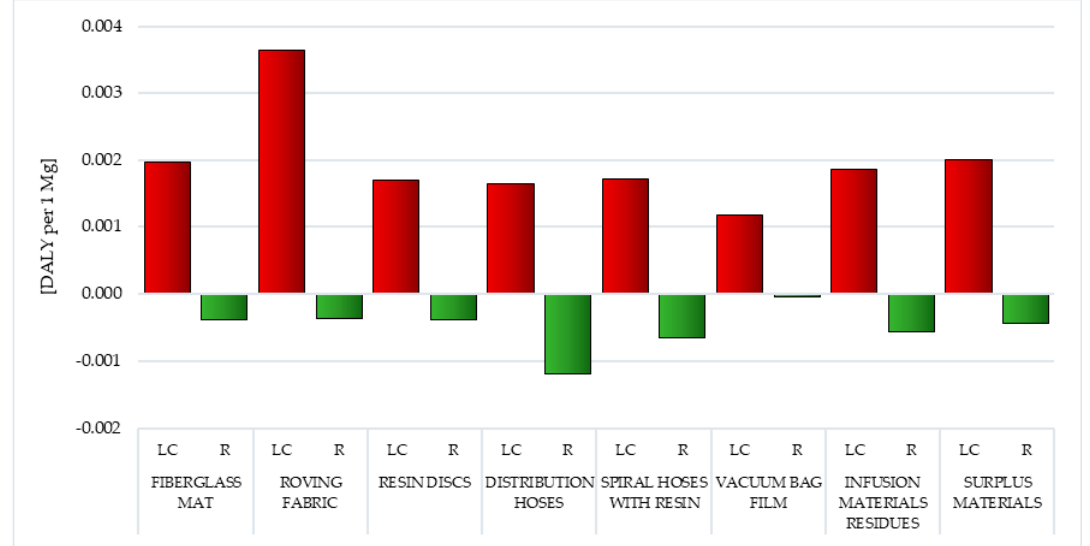
Figure 6. Characterization results of environmental consequences for inorganic compounds causing respiratory diseases present in selected postproduction waste of wind power plant blades: LC—life cycle, R—recycling [unit: DALY per 1 mg].